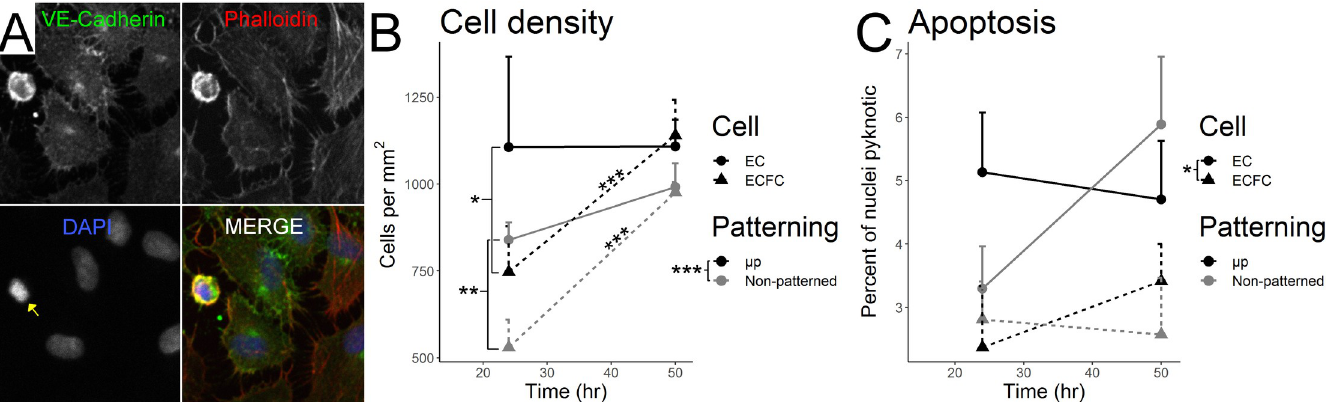
Fig 2. Micropatterned cells show subcellular alignment and peripheral aggregation of actin. ECFCs and ECs were stained and imaged using laser scanning confocal microscopy with a super-resolution airyscan detector in order to assess actin distribution and alignment after 24 hours of culture. Representative images of non-patterned ECFCs (A), micropatterned ECFCs (B), non-patterned ECs (C), and micropatterned ECs (D) after 24 hours in culture are shown. Each image series shows phalloidin (actin), VE-Cadherin, and a pseudocolor merge with phalloidin in green, VE-Cadherin in red, and a DAPI nuclear stain in blue. Main panel scale bars are 20 μ m. Inset panels are 10X maximum Z-projections, with scale bars of 100 μ m.